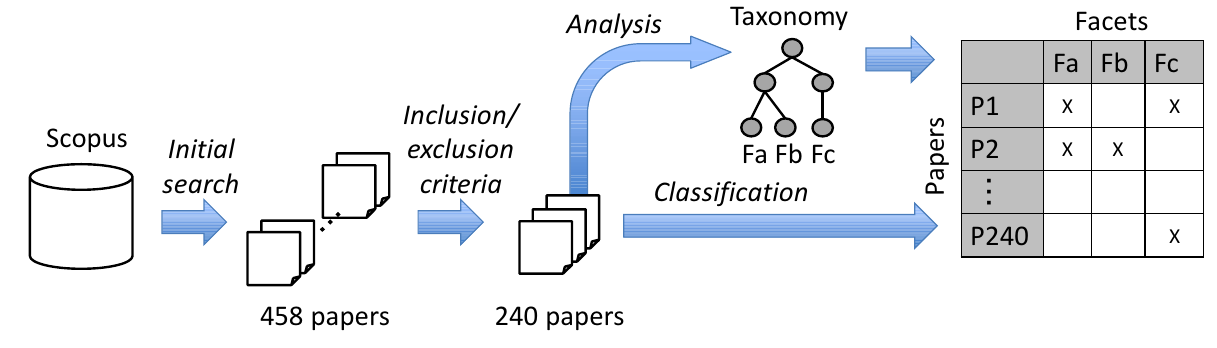
Figure 1. Taxonomy construction